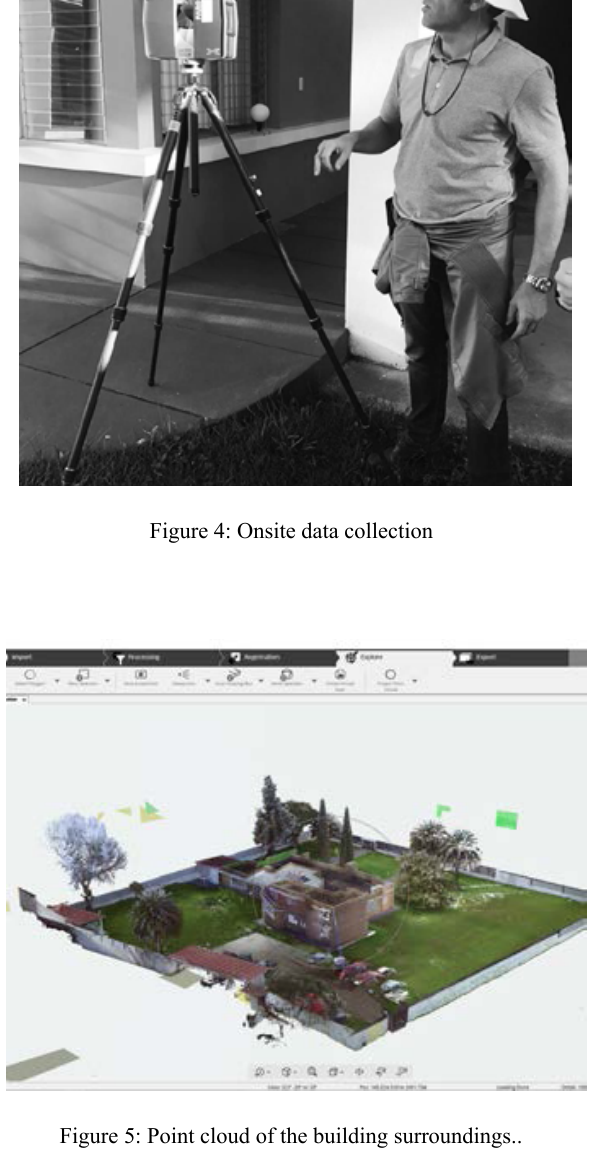
Figure 5: Point cloud of the building surroundings..